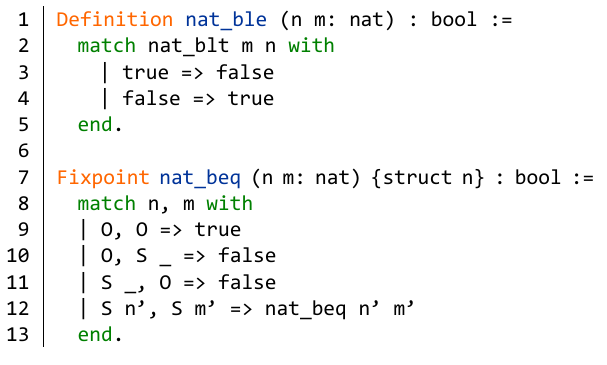
Figure 3. Definitions of conversion